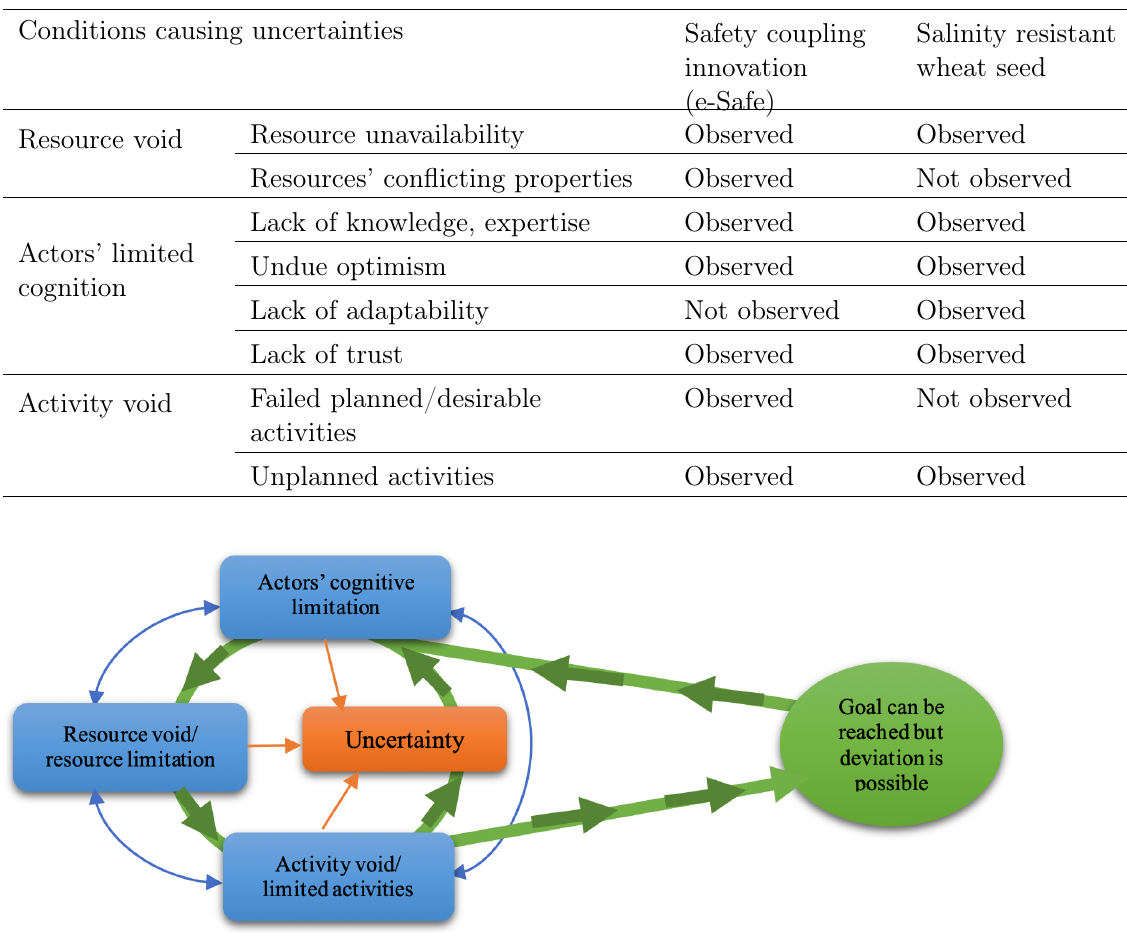
Table 1. Conditions under which uncertainties emerged in the innovation process of e-Safe and SRHYWV seeds